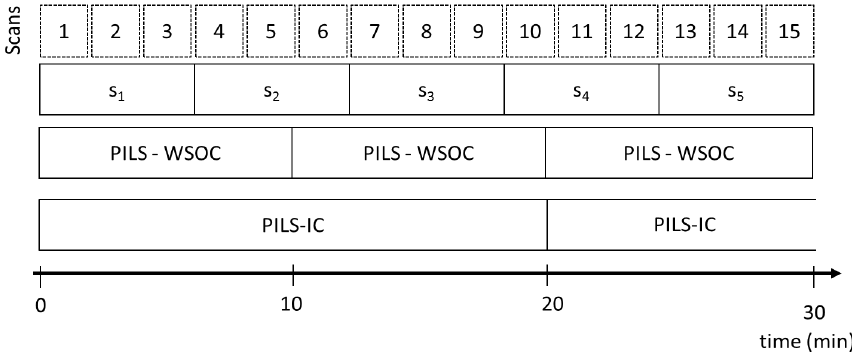
Fig. 5. Coordination of measurements used in this study for each 30min measurement cycle. s is the symbol for “supersaturation”; PILS- WSOC, PILS-IC stand for “Particle-In-Liquid-Sampler” for water soluble organic carbon and inorganic ions,